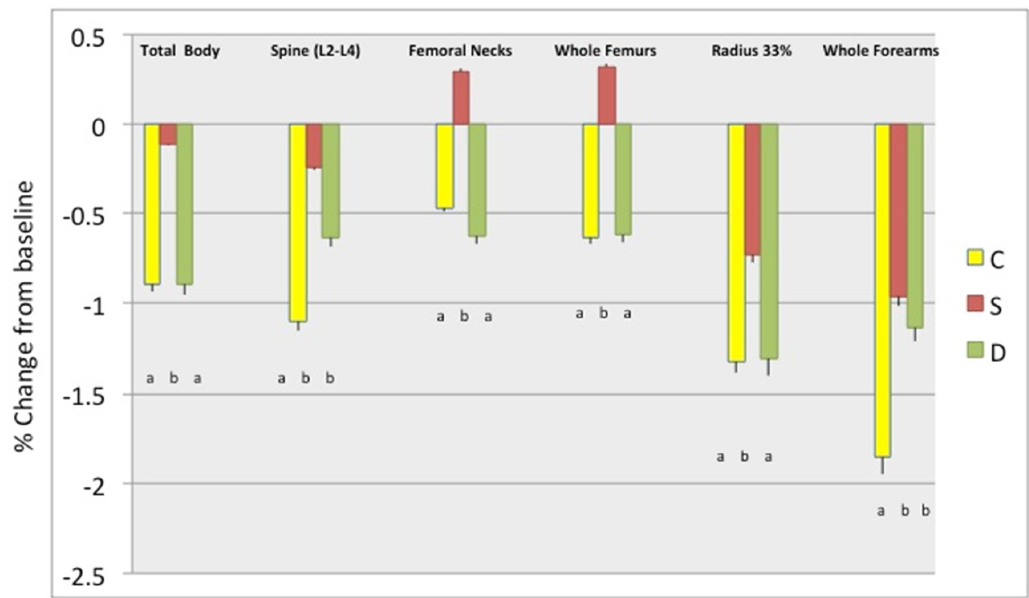
Figure 5. Percent change in bone mineral density (BMD) (mean ± SEM) of various skeletal sites between baseline and 6 months among the groups. Only the complete data sets at baseline and 6-months were used: C-Control / placebo, n = 30; S-Supplement, n = 37; D-Dairy, n = 30 were used for these analyses. BMD presents average values for both (left and right) femoral necks, both whole femurs (neck, Ward’s triangle, trochanter, and shaft), both radius 1 / 3 of styloid process, and both whole forearms (ulna and radius at ultradistal and 1 / 3 site). Bars with di ff erent letters indicate the statistically significant di ff erence among the groups at 6